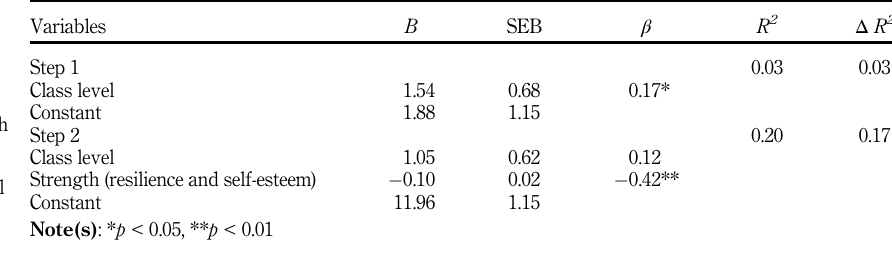
Table 2. Hierarchical multiple regression analysis summary for strength (combined resilience and self-esteem), controlling class level variable, predicting